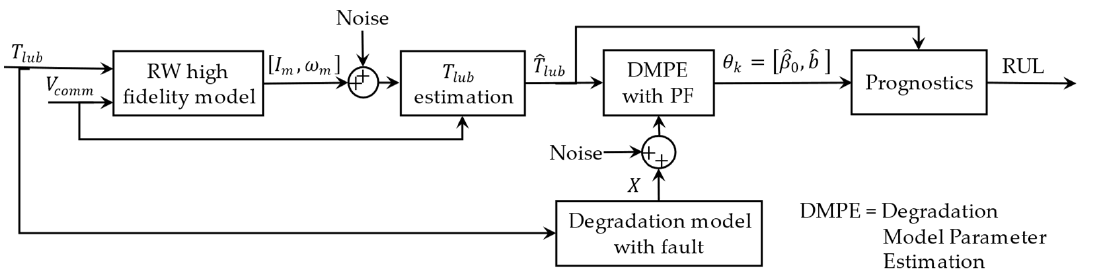
Figure 8. The flow of temperature estimation leads to online parameter estimation for the degrada- tion model and